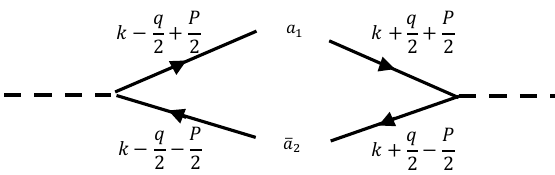
Figure 1 . Diagram of the Double Parton Distribution Function associated to eq. (2.15). Open vertices represent nonlocal current insertions.